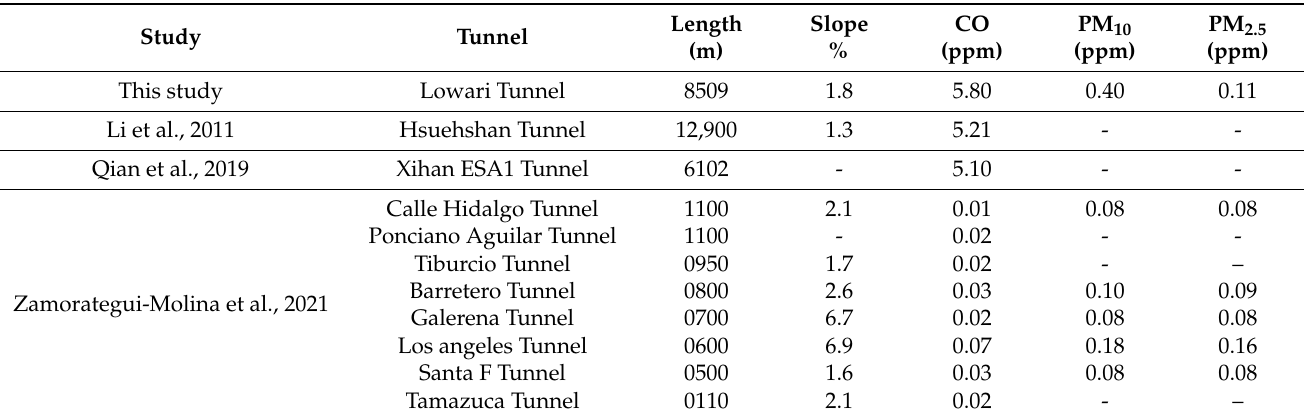
Table 3. Comparison of the tunnels’ pollutant concentrations during the operational